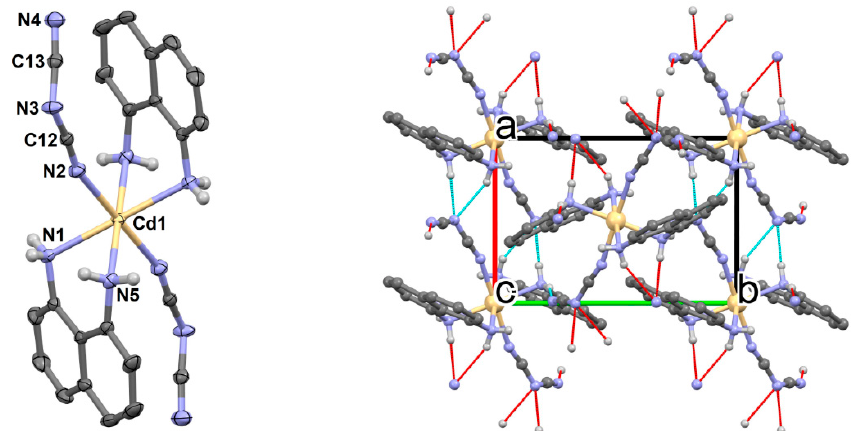
Figure 6. Coordination ( left ) and H-bonded network with bcu topology ( right ) of complex 6 . Dotted lines indicate H-bonds. (Color code: yellow, Cd; blue, N; black, C; gray, H).